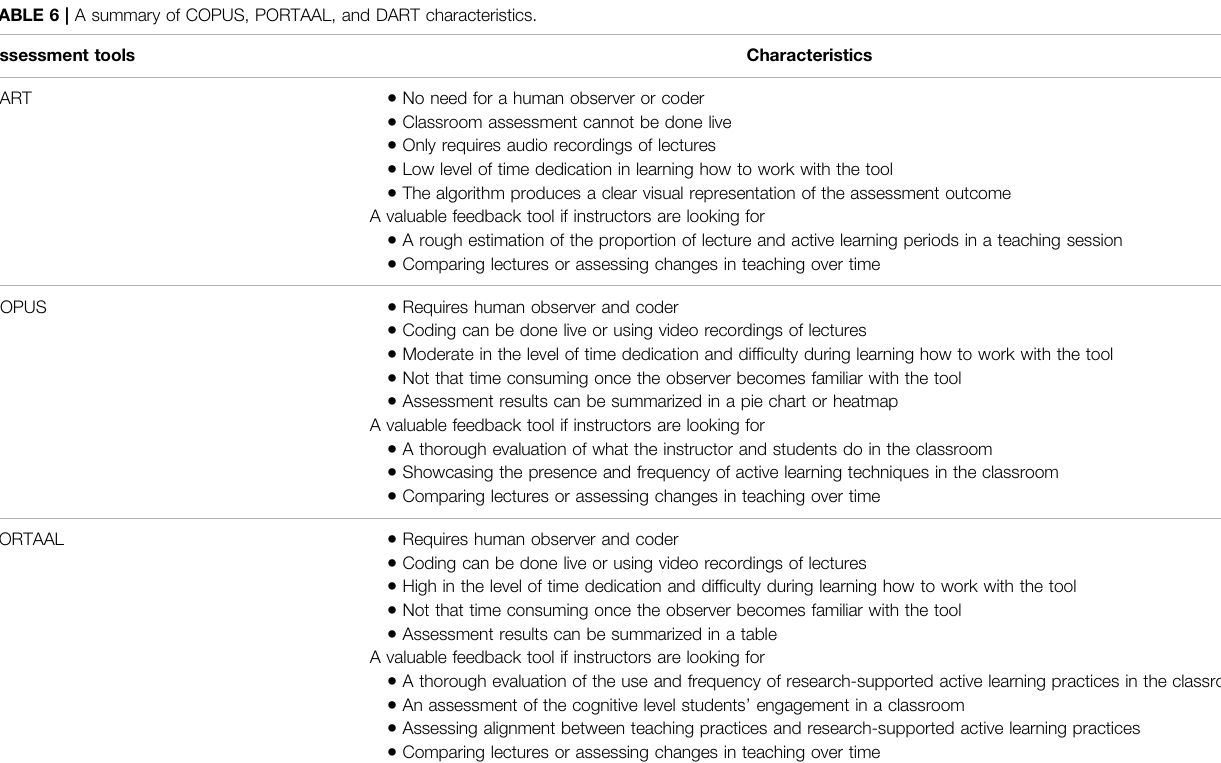
TABLE 6 | A summary of COPUS, PORTAAL, and DART characteristics. Assessment